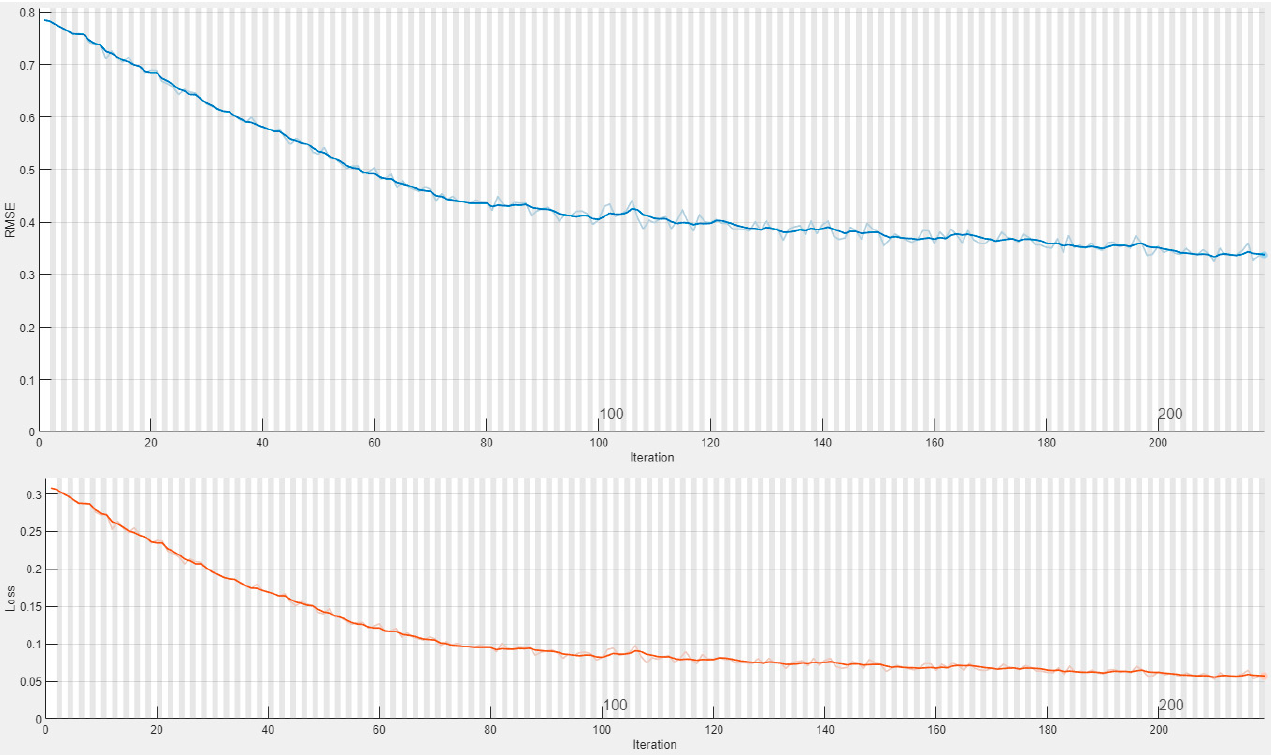
Figure 13. Training loss curve of LSTM. Blue line shows the RMSE loss and red line shows model performance loss in terms of mean squared error (MSE) loss.